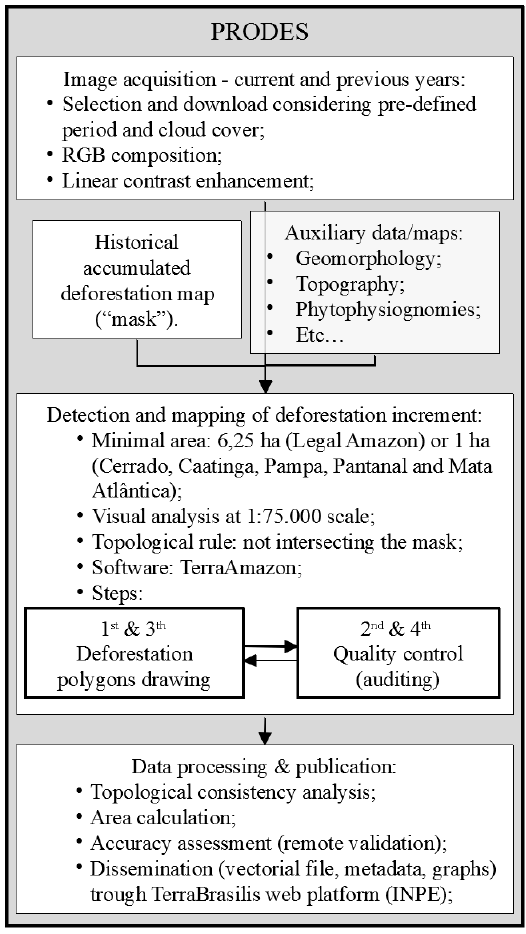
Figure 5. Pictorial representation of the PRODES methodology.